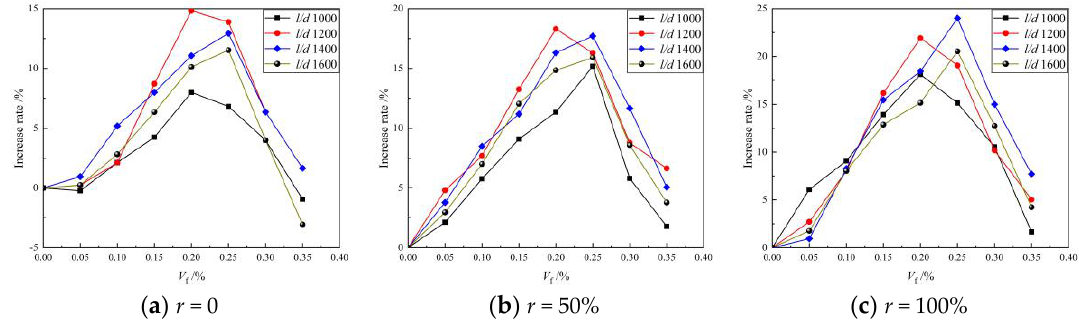
Figure 4. Relation between BFRAC cube compressive strength and BF volume fraction.